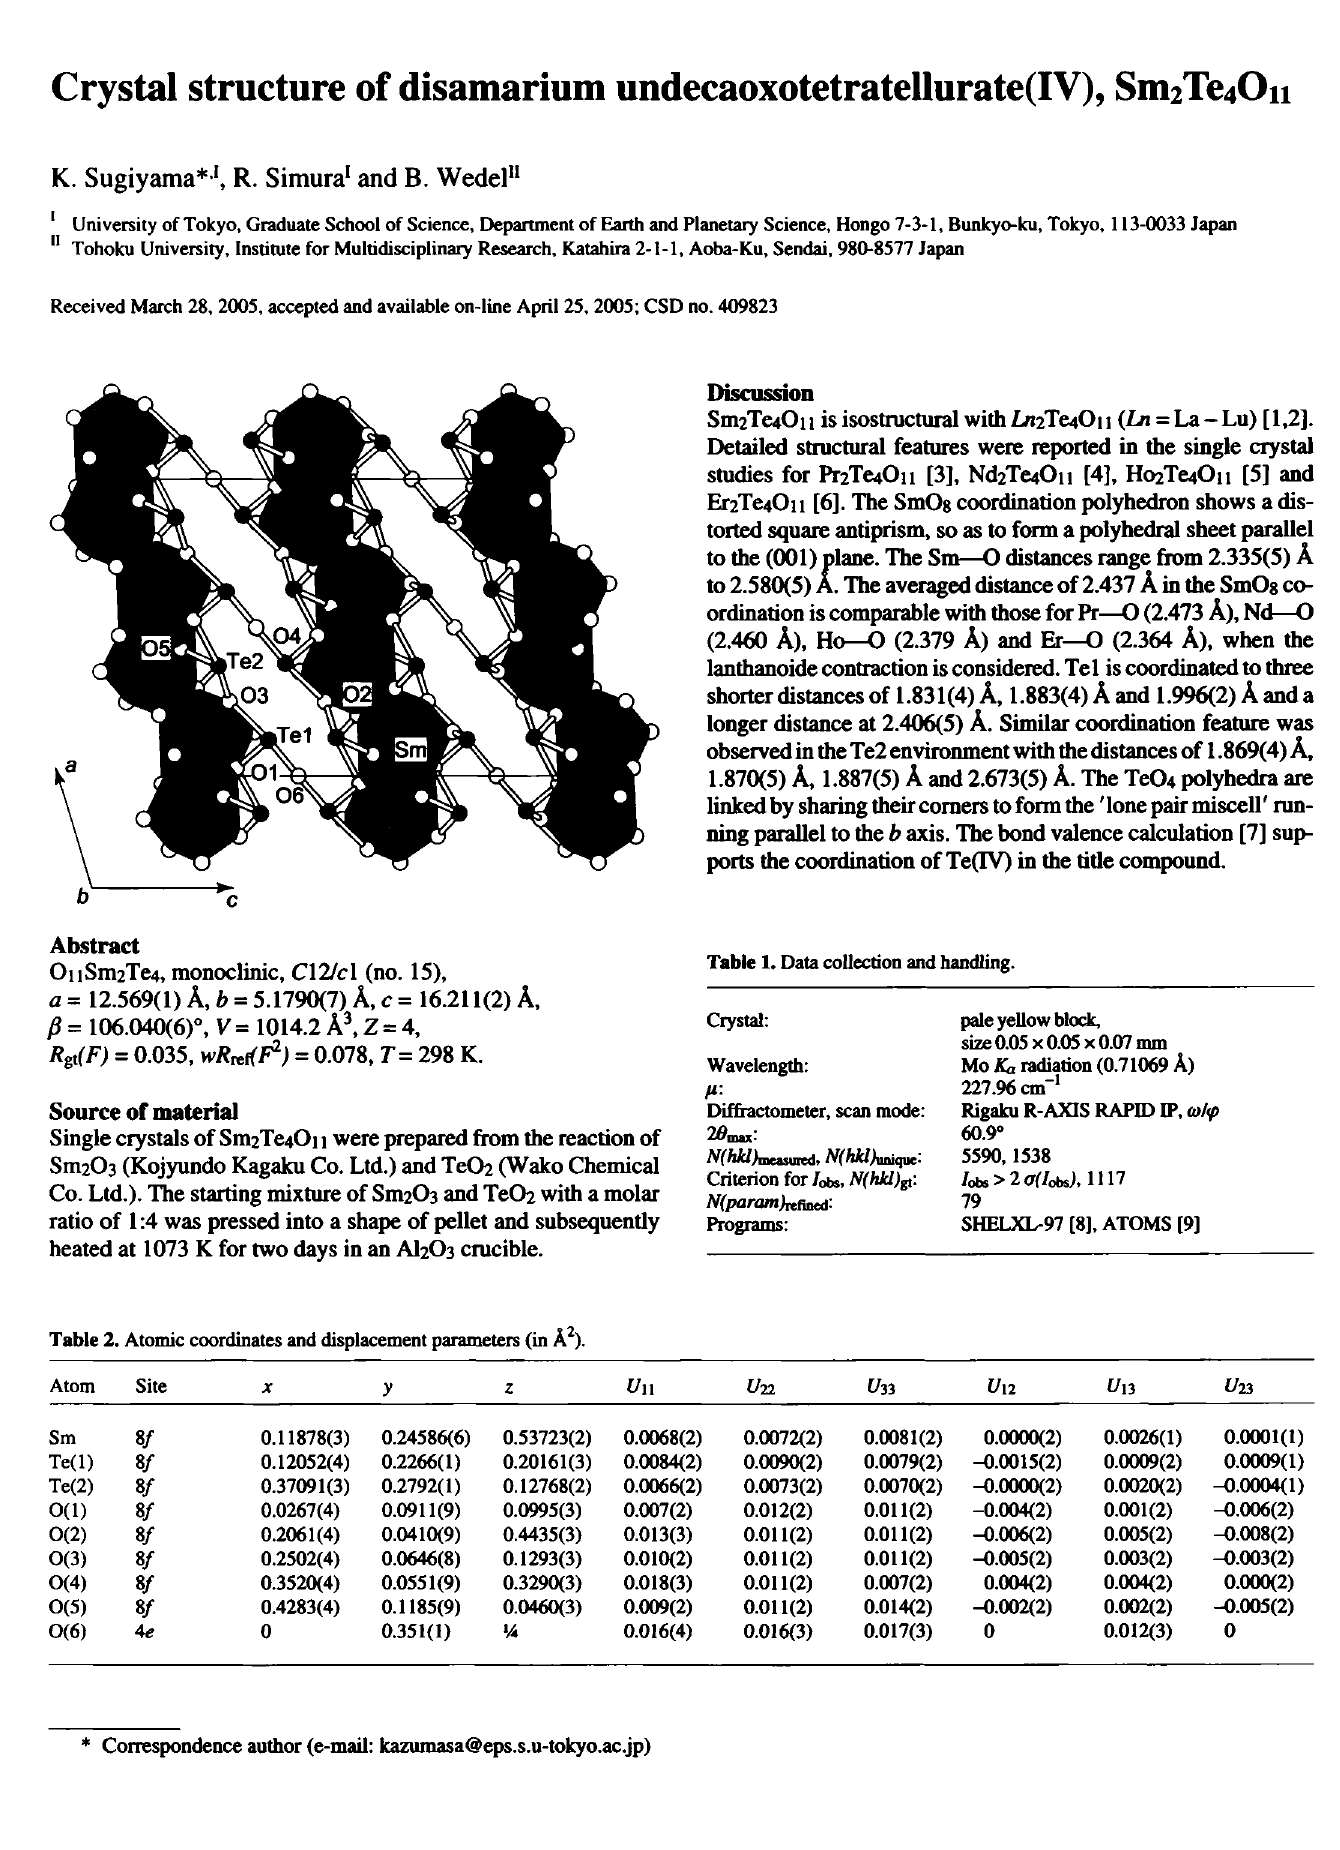
Table 2. Atomic coordinates and displacement parameters (in Ä 2